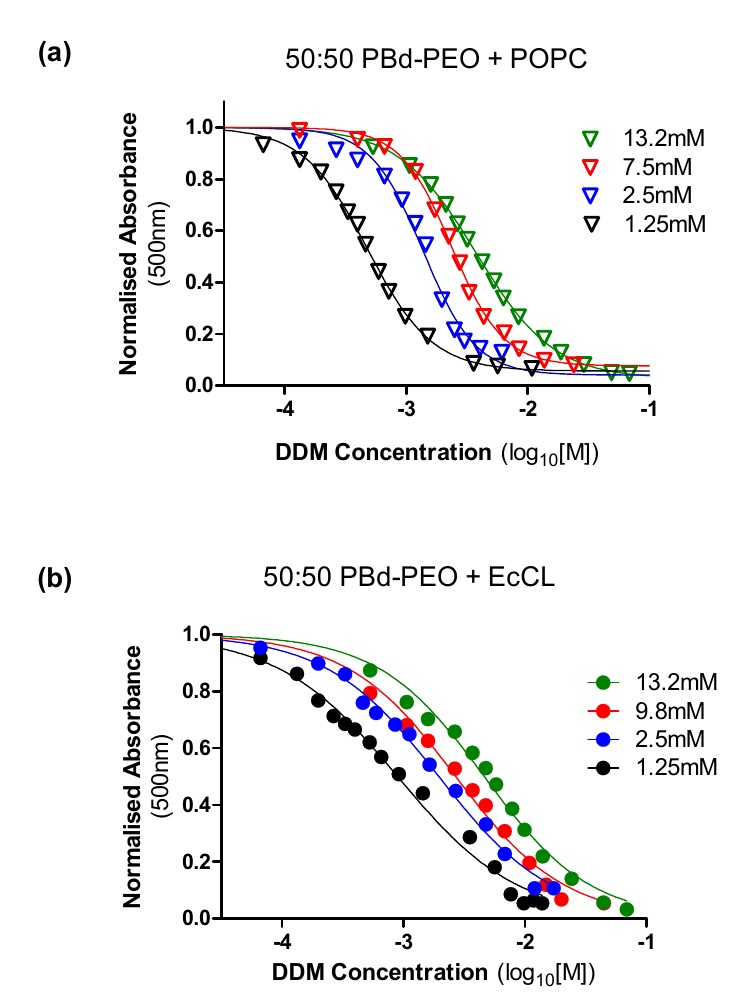
Figure 4. Effects of increased hybrid polymersome amount on solubilisation parameters. DDM (10 − 4.5 to 10 − 1 M) was used to solubilise varying concentrations (1.25–13.2 mM) of hybrid vesicles containing 50 mol% PBd-PEO and 50 mol% of lipid comprising either ( a ) POPC or ( b ) EcCL. Absorbance (optical density) was measured at 500 nm in a 1 cm path length quartz cuvette. Detergent was added and the signal was monitored continuously. Data were normalised to the optical density in the absence of detergent. The dose-response equation (variable slope) was fitted to the data using non-linear regression.